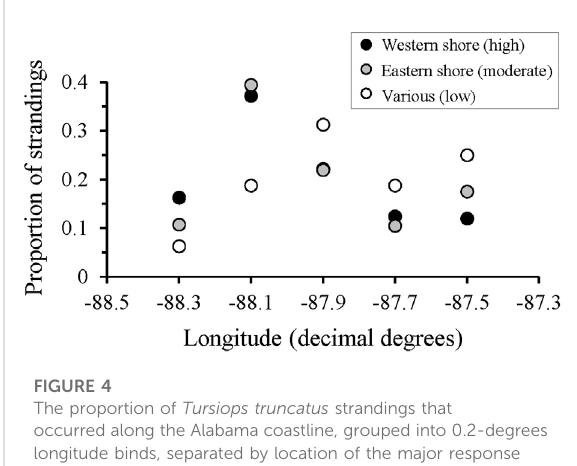
FIGURE 4 The proportion of Tursiops truncatus strandings that occurred along the Alabama coastline, grouped into 0.2-degrees longitude binds, separated by location of the major response agency and associated level of response effort (locations and effort metrics are detailed in Supplementary Table S1).